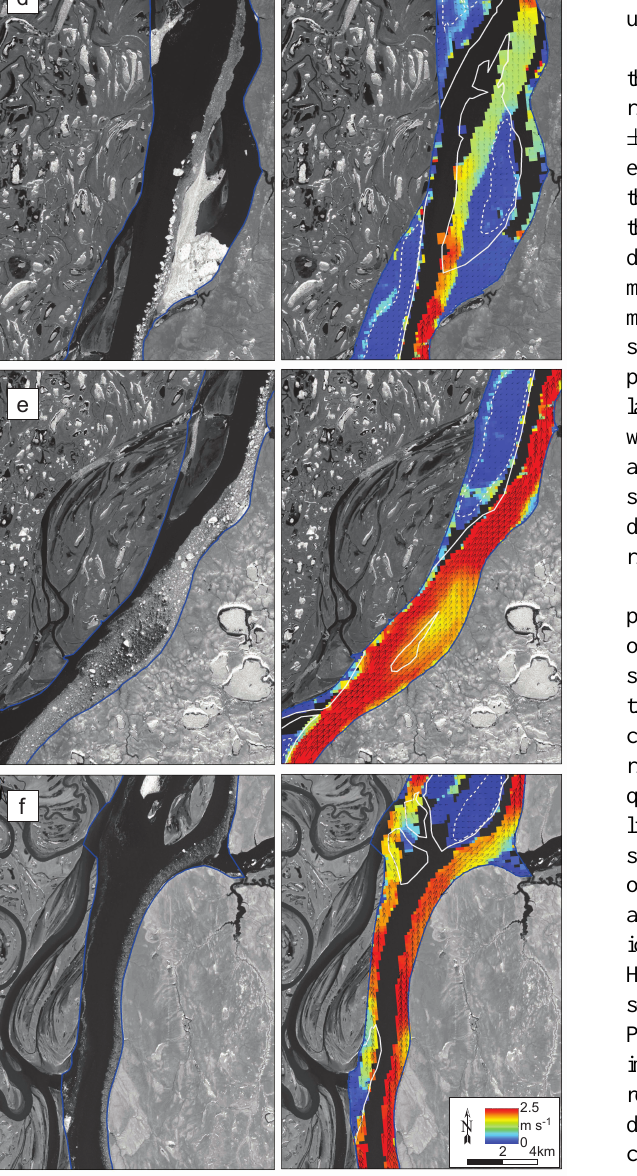
Fig. 8. Raw ASTER satellite imagery of 27 May 2011 used for ice tracking (left column) and velocity fields measured (right column). Sand bars (solid white lines) and vegetated islands (dotted white lines) from low-water conditions as of 21 August 2011. Speeds are colour coded. Velocity vectors (originally a 165m × 165m grid) are for resampled to a 330m × 330m grid better visibility. For locations of sites (lower-case letters) see Figs. 4 and